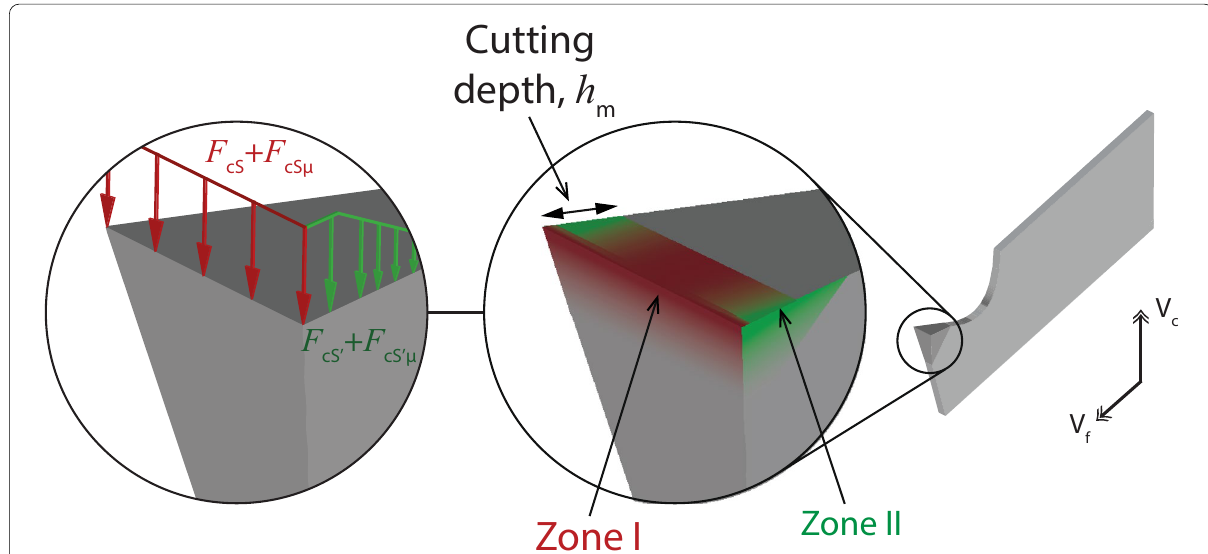
Fig. 4 The cutting force can be divided into two zones: Zone I major cutting edge force ( F cS ) and friction forces on the major first flank ( F cS µ ) and